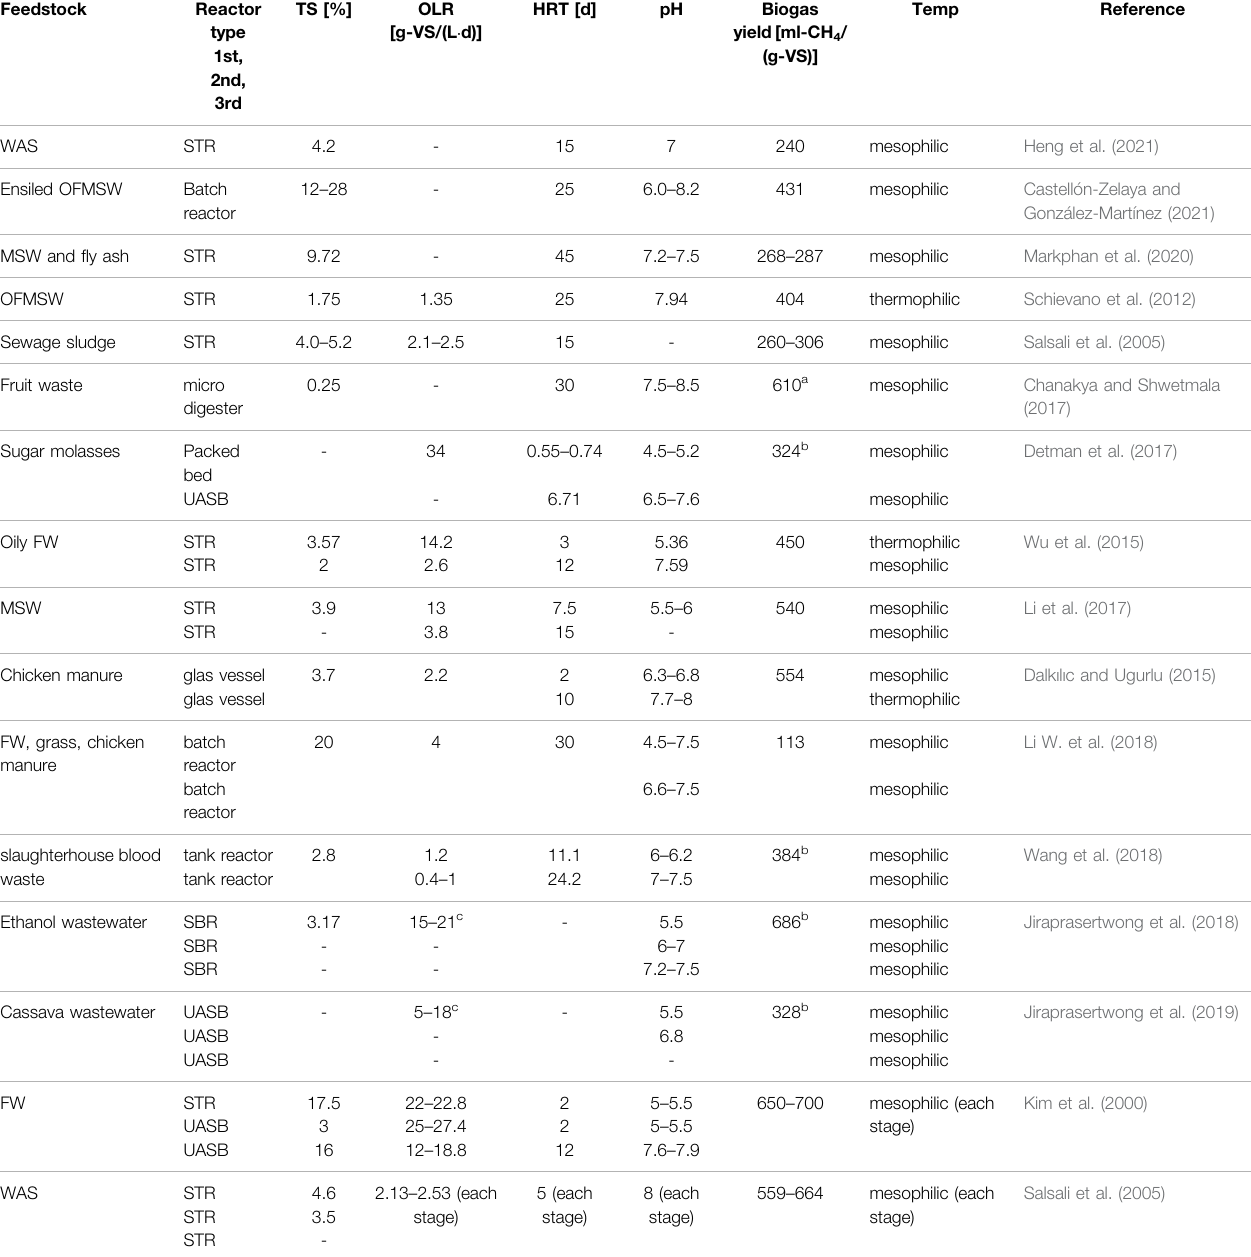
TABLE 2 | Examples for one-, two- and three-stage phase separation applications in anaerobic digestion.